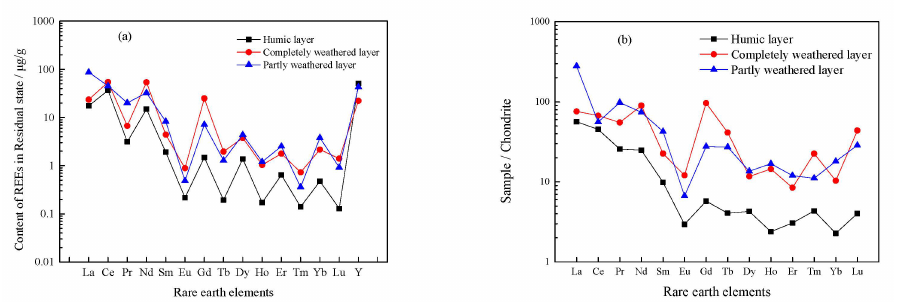
Figure 12. Contents of rare earth in residual state and chondrite standards. ( a ) Content of residual state rare earth elements in each weathered layer; ( b ) Standard for residual state rare earth element chondrites in each weathered